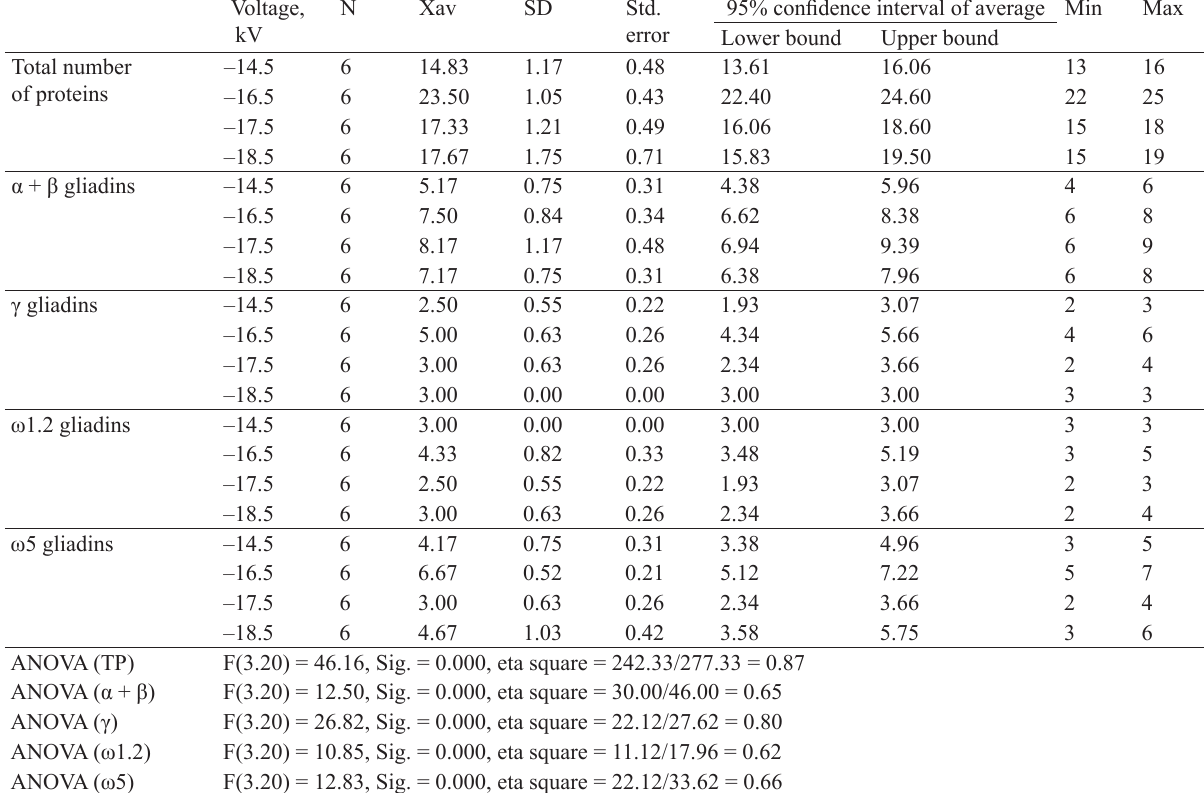
Table 6 Descriptive indicators of total proteins and the number of gliadin fractions (solvent 70% ethanol, Agilent, CE